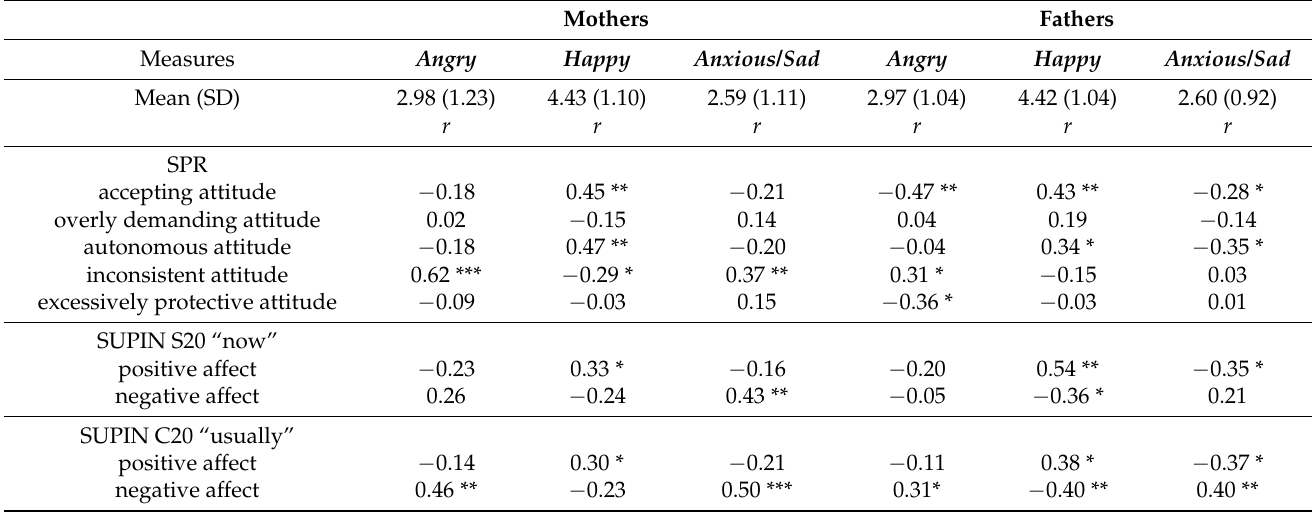
Table 6. Correlations between PFI factors and variables of interest for mothers and fathers (N = 95). Mothers Fathers Angry Happy Anxious / Sad Angry Happy Anxious /